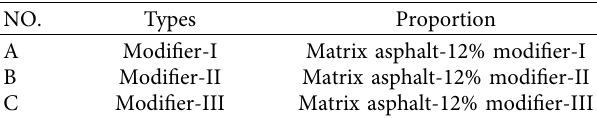
Table 5: The selected high-performance